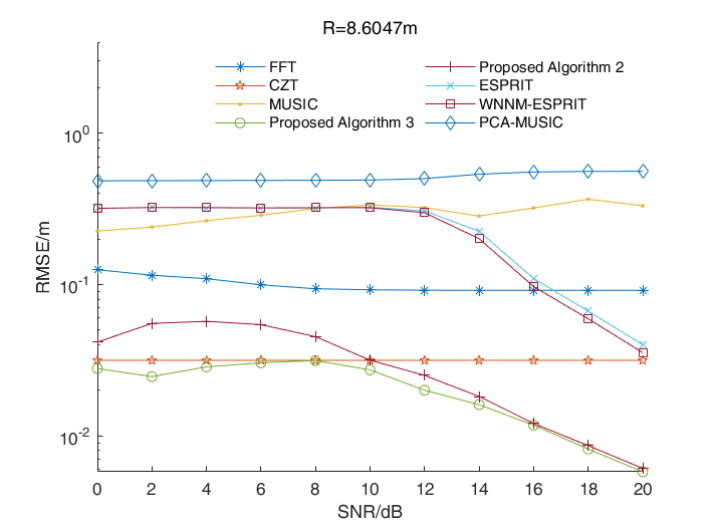
Figure 8. The RMSE values of the distance estimations versus the SNR values of various algorithms when R = 8.6047